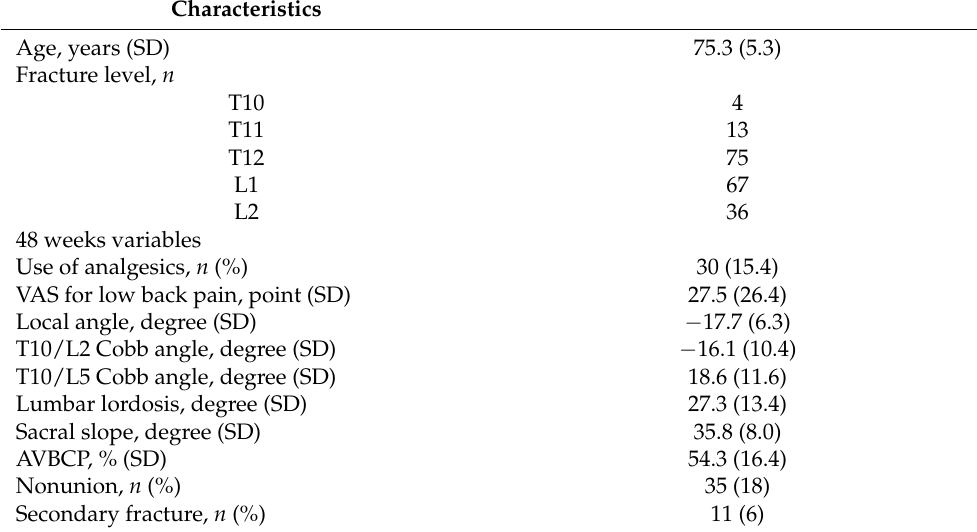
Figure 1. Study participant flow diagram. During the study period, 382 patients were assessed for eligibility. The original study enrolled 284 patients. During the follow-up period, an additional 89 patients were excluded. MRI, Magnetic resonance imaging Table 1. Patient demographics.